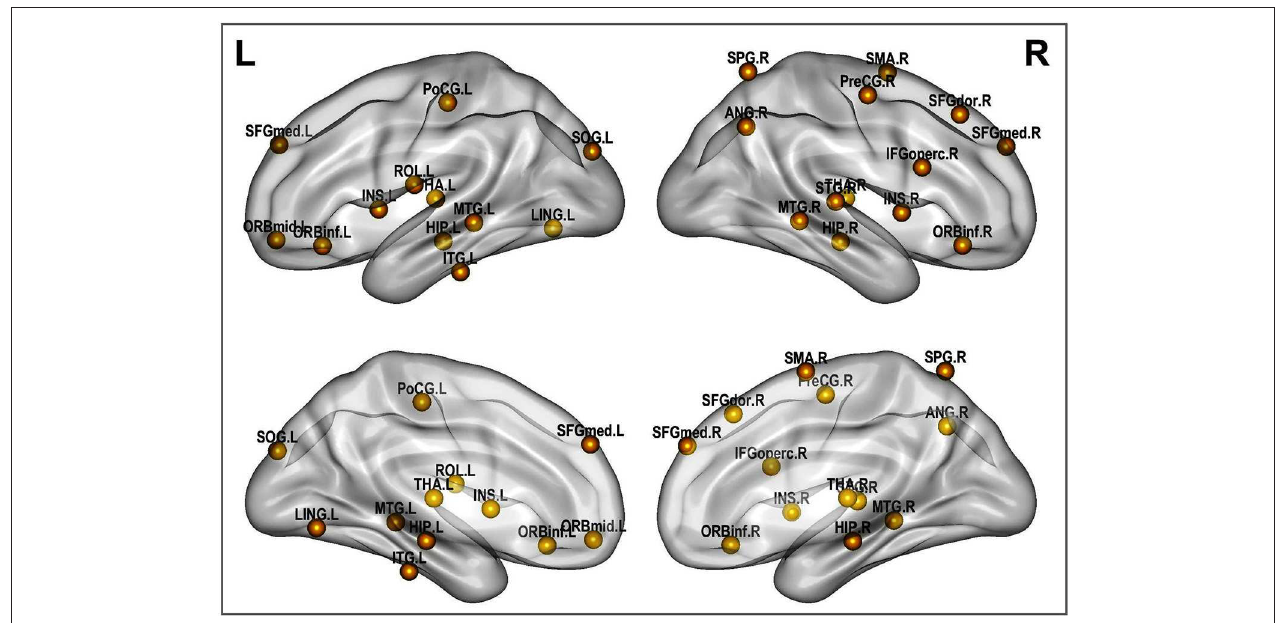
FIGURE 8 | Altered brain regions in autism as revealed by ROI community assignment test. This test was conducted on pooled data across experimental